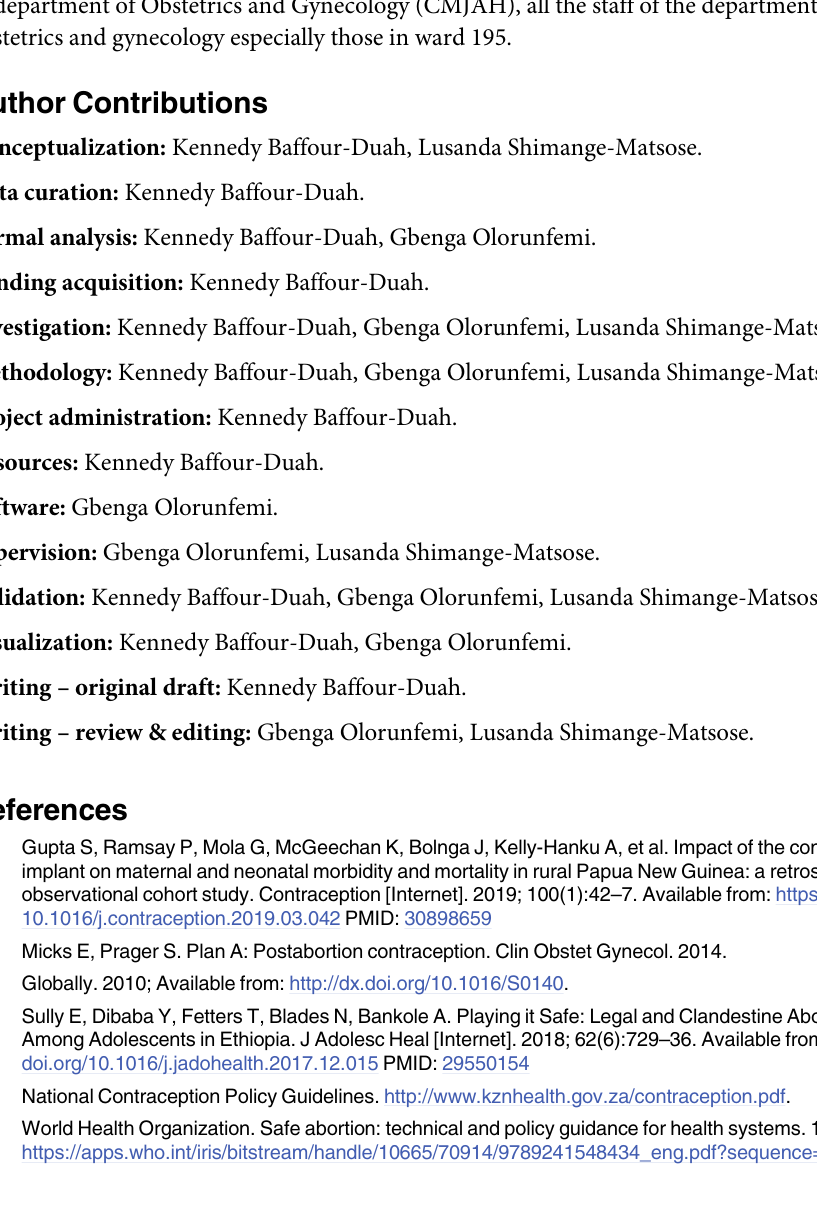
S1 Table. Annual trends in number of abortions stratified by age groups and gestational age. S2 Table. Trends in the contraceptive mix among women who had induced abortion